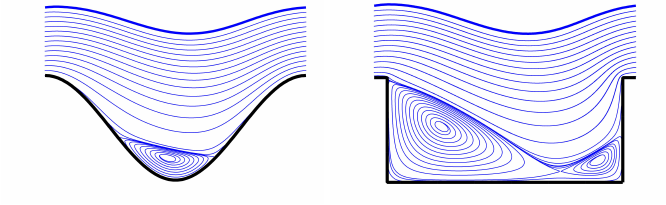
Figure 5. Streamlines elucidating steady film flow over two different periodically corrugated inclined surfaces: on the left a smoothly varying feature, on the right a feature involving sharp, step changes.